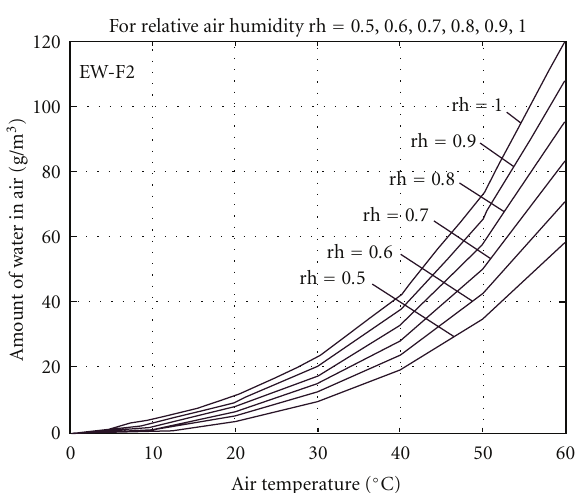
Figure 14: Amount of water in 1m 3 of air versus air temperature and relative humidity (rh).